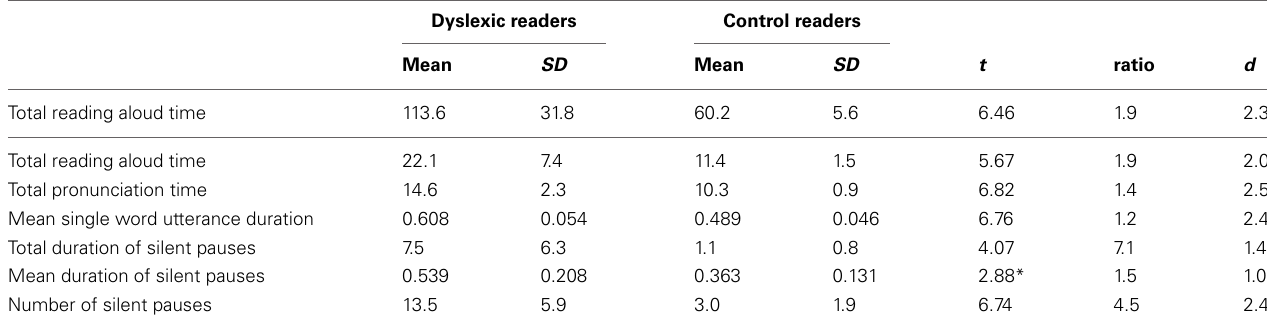
Table 2 | Group results for reading aloud data based on the audio